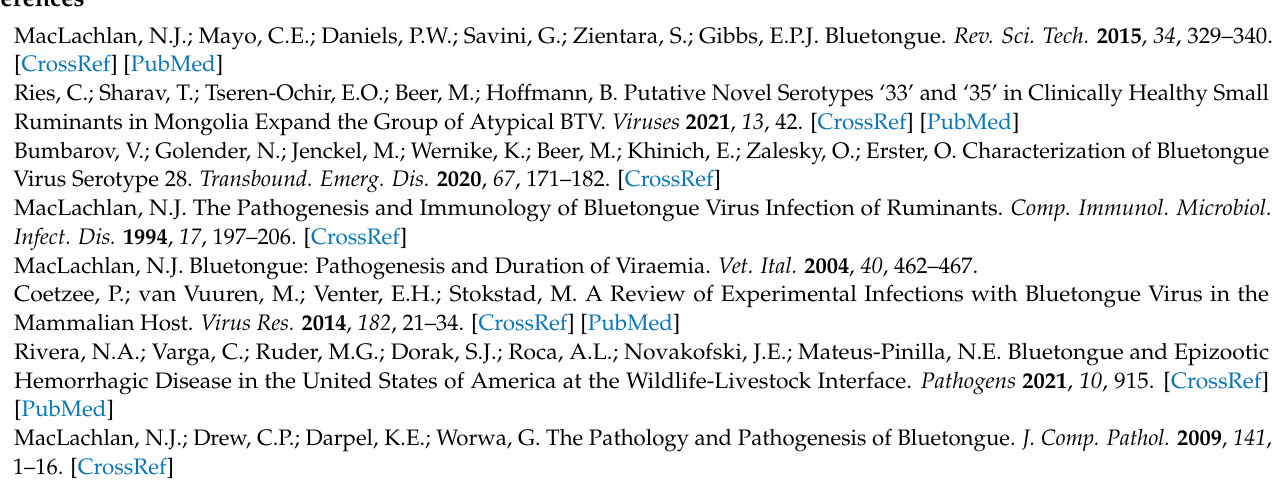
Figure S2: Model variability for Culicoides insignis : median of variance coming from GCMs (A), SSPs (B) and replicates (C) in future climate scenarios; Figure S3: Scatterplot of bluetongue virus in an environmental space. Gray points are the projection area (Peru) while purple circles are used for occurrences in the ENM model; Figure S4: Scatterplot of Culicoides insignis in an environmental space. Gray points are the projection area (Peru) while red circles are used for occurrences in the ENM model; Table S1: Occurrence records of bluetongue virus and Culicoides insignis ; Table S2: Set of bioclimatic variables used for construction of the ENM for bluetongue virus; Table S3: Set of bioclimatic variables used for construction of the ENM for Culicoides insignis